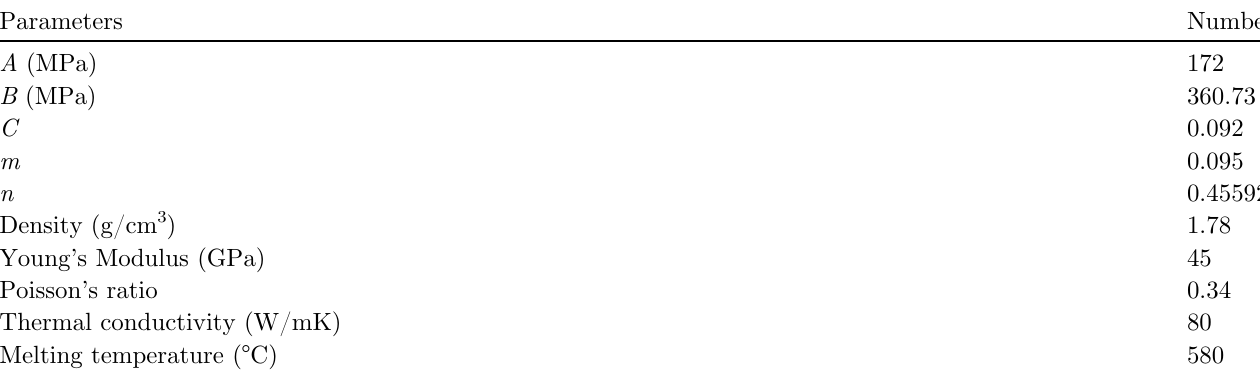
Table 2. Properties of AZ31B [41]. Used in proposed